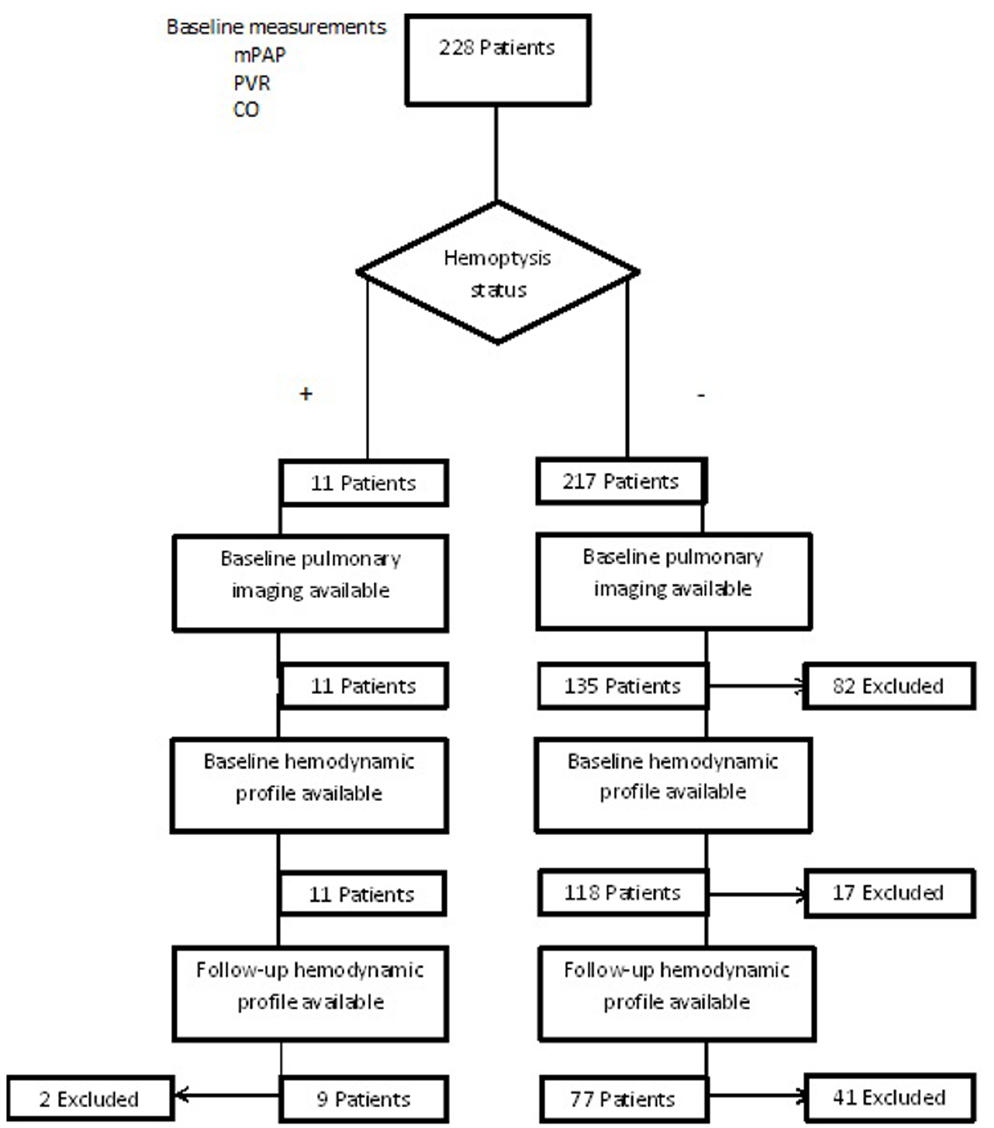
Figure 1. PAH Study cohort. Studies performed within 12 months of the original diagnosis were considered baseline data. Pulmonary imaging consisted of CT angiography and/or thoracic